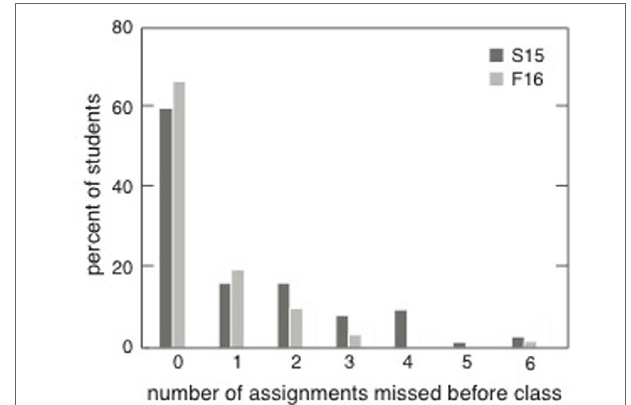
FigUre 9 | Histogram of the number of assignments students fail to complete before class, in each